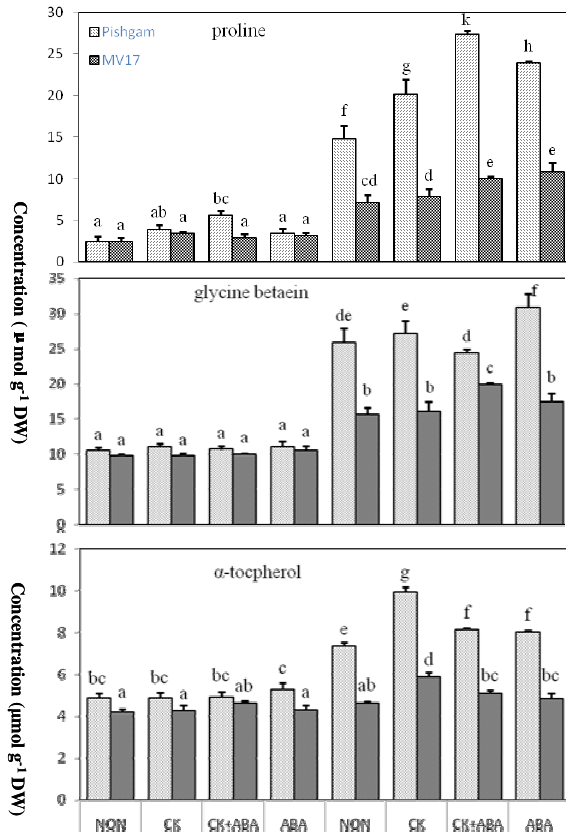
Fig. 3. Effect of hormonal treatments of CK, ABA and CK/ABA on glycinebetaine and proline content under irrigation and drought condition in flag leaves during grain filling in two wheat cultivars (drought tolerant cv. ‘ Pishgam ’ (white columns) and drought sensitive cv. ‘ MV-17 ’ (black columns). Data are shown as mean ± SD of three independent